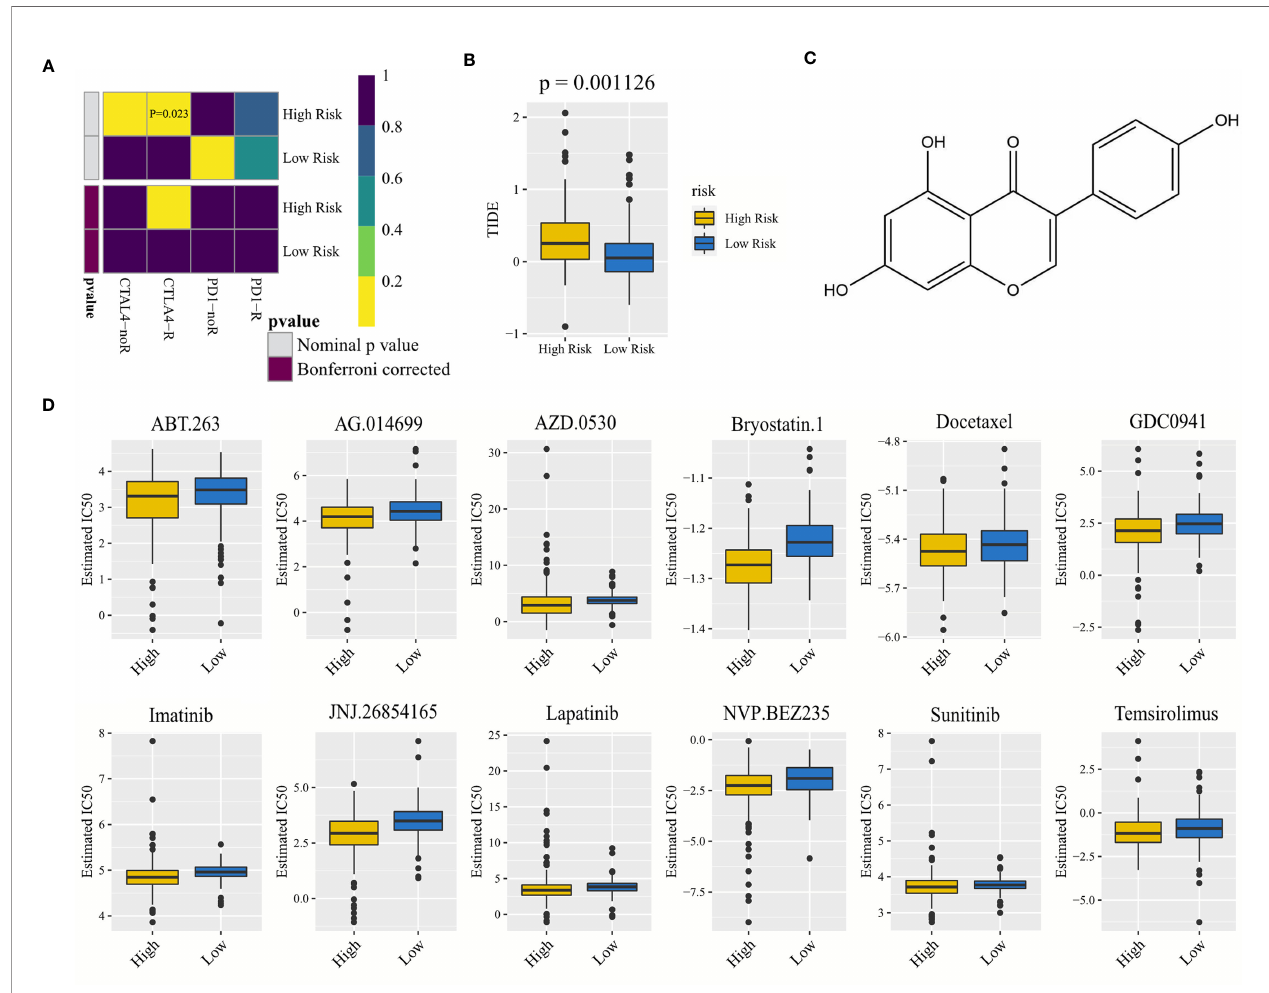
FIGURE 8 | Correlated with anti-CTLA4 and anti-PD-1 immunotherapy, drug screening, and drug IC 50 prediction. (A) Heat map exploring the response of anti- CTLA4 and anti-PD-1 immunotherapy for gastric adenocarcinoma in the high- and low-risk groups. CTLA4-noR, anti-CTLA4 immunotherapy did not respond; CTLA4-R, anti-CTLA4 immunotherapy responded, and so on. Including nominal P -value and Bonferroni corrected P -value. (B) Difference in the TIDE score between the high- and low-risk groups. (C) Structure of the small-molecule drug genistein. Genistein is a natural aromatic oxygenated heterocyclic compound, which can inhibit the expression of risk-model-related genes and lead to apoptosis of gastric cancer cells. (D) Differences in IC 50 , estimated between the high- and low-risk groups, of 12 drugs that were conducive to reducing the risk of gastric adenocarcinoma and improving survival. TIDE, tumor immune dysfunction and exclusion; IC 50 , half-maximal inhibitory